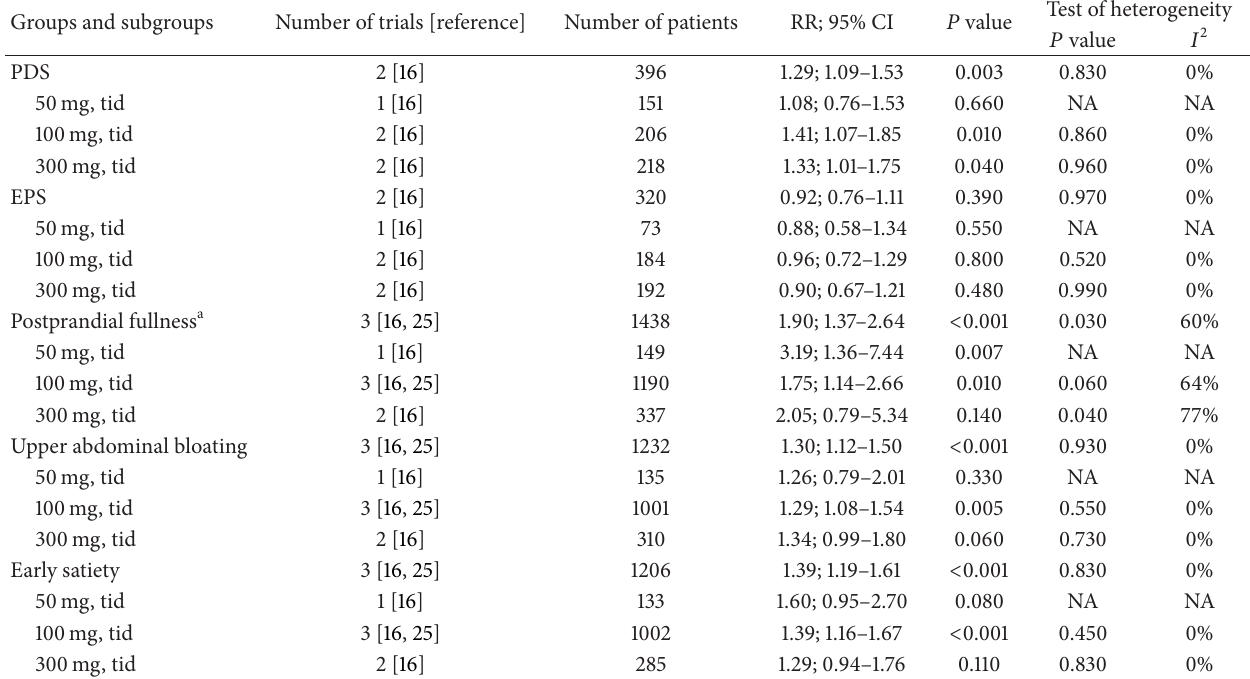
Table 2: Pooled RR of acotiamide versus placebo for elimination of FD symptoms by Mantel-Haenszel fixed-effect model. Groups and subgroups